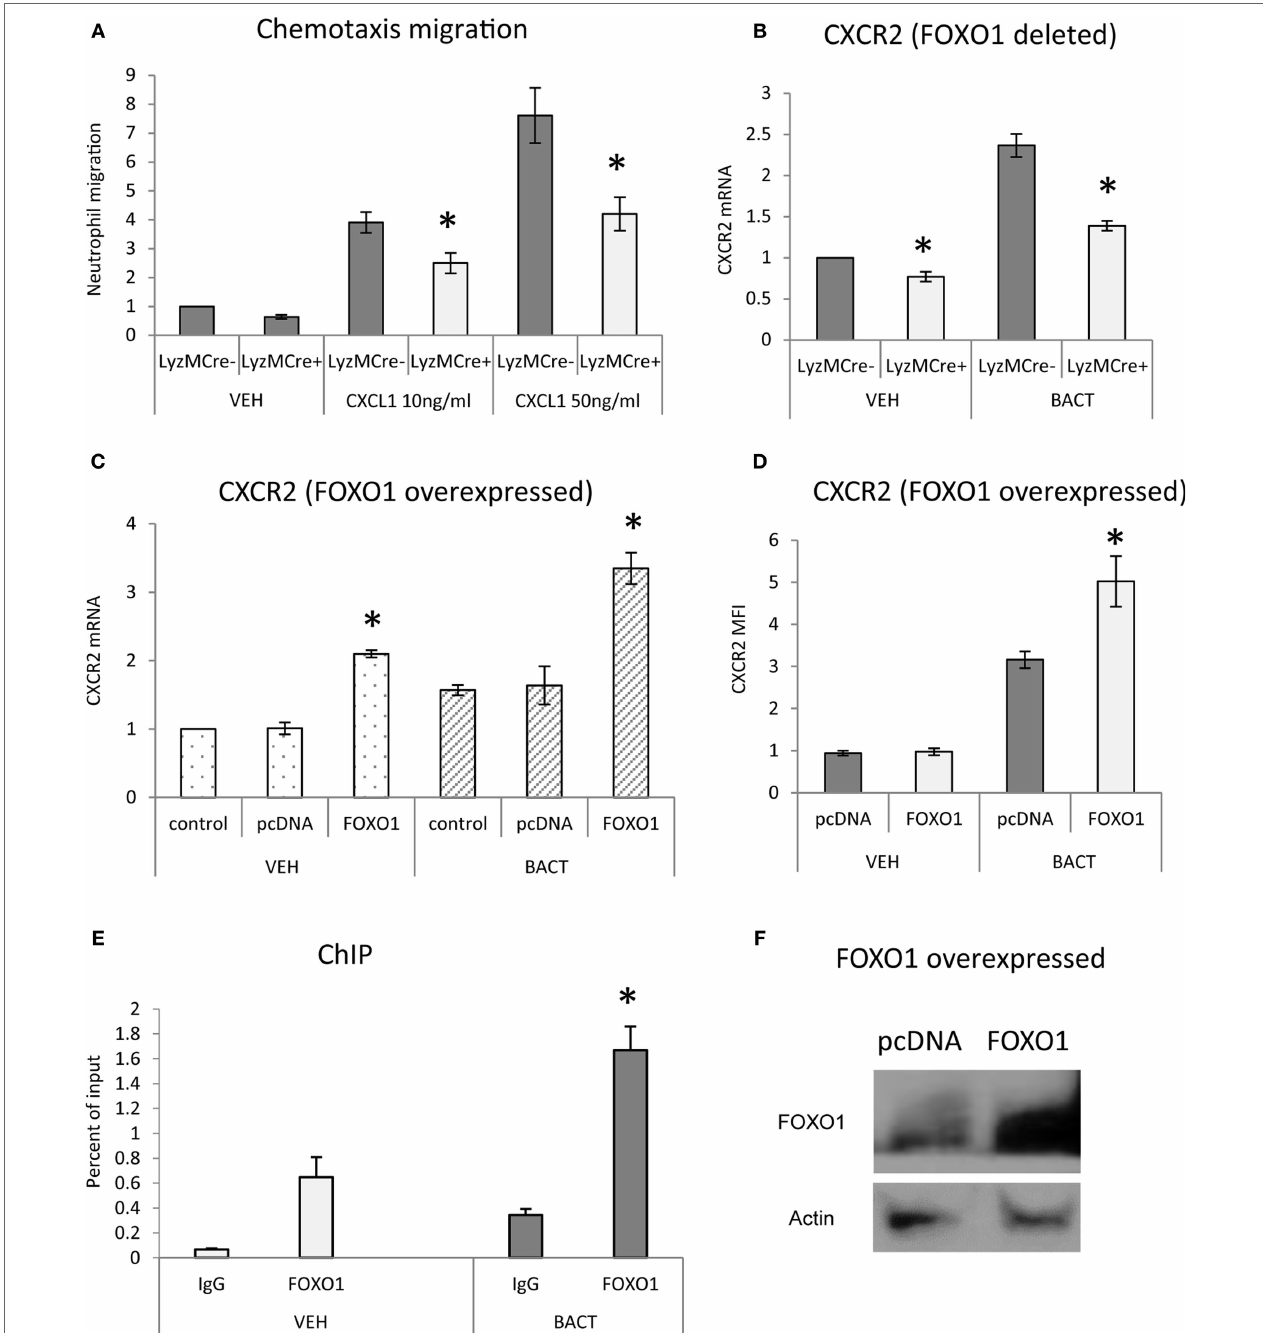
FigUre 2 | FOXO1 is needed for neutrophil migration and CXCR2 expression. (a) Migration was examined in neutrophils from FOXO1-deleted LyzM.Cre + FOXO1 L/L mice or littermate control LyzM.Cre − FOXO1 L/L mice in transwell chambers. CXCL1 was added to the bottom chamber and neutrophils that migrated to the bottom chamber were quantified following DAPI staining and fluorescence microscopy. (B) Bacteria were incubated with neutrophils from FOXO1-deleted LyzM. Cre + FOXO1 L/L and control LyzM.Cre − FOXO1 L/L mice. CXCR2 mRNA levels were measured by RT-PCR and normalized to ribosomal protein L32. (c) HL-60 neutrophils were transfected with FOXO1 or empty vector alone and stimulated with bacteria or vehicle alone. RNA was isolated from neutrophils. CXCR2 expression was measured by real-time PCR. (D) CXCR2 protein levels were assessed by mean fluorescence intensity (MFI). (e) Chromatin immunoprecipitation (ChIP) assays were performed with neutrophils from control LyzM.Cre − FOXO1 L/L mice. (F) HL-60 neutrophils were transfected with FOXO1 expression plasmid or empty vector alone and FOXO1 protein levels were measured by immunoblot with a specific antibody. Actin was assessed as a loading control. The data are representative of two or three independent experiments. Data are expressed as the mean ± SEM from triplicate samples. *Significant difference between neutrophils from FOXO1-deleted LyzM.Cre + FOXO1 L/L mice and littermate control LyzM.Cre − FOXO1 L/L mice ( P < 0.05). *Significant difference between HL-60 neutrophils from transfection of FOXO1 vs. empty vector alone ( P <